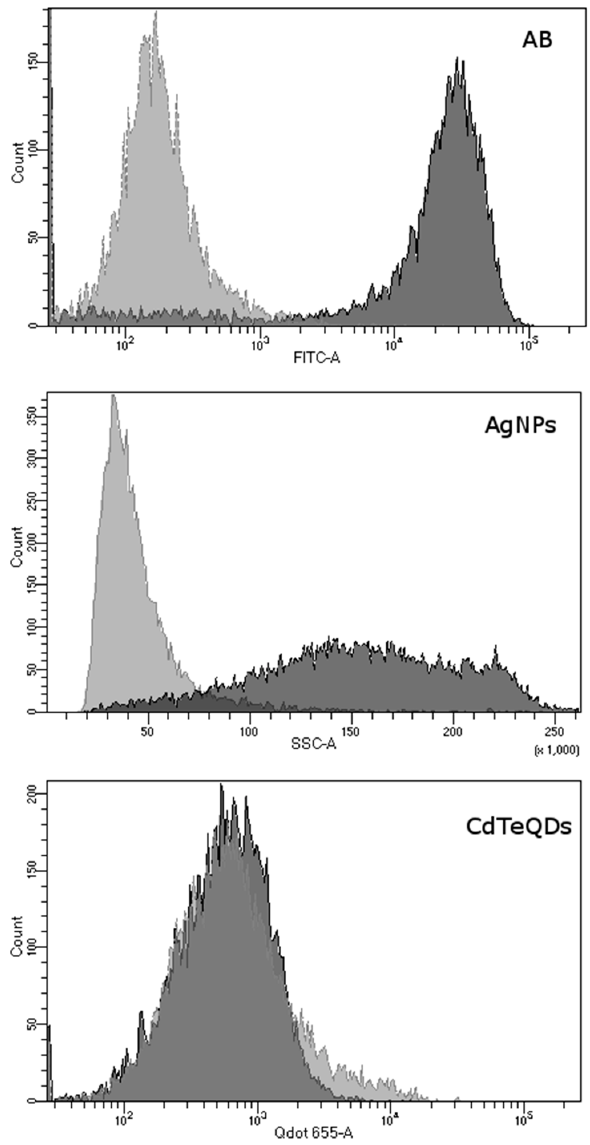
Figure 6. Uptake of A β , AgNP and CdTeQD by BV-2 cells preincubated with polyinosinic acid (PA). The cells were pretreated (or not) with PA, 50 µ g mL − 1 for 30 min, then A β -HiLyte Fluor 488 (0.1 µ M), AgNP (50 µ g mL − 1 ) or CdTeQD (10 µ g mL − 1 ) were added for 2 h. Light grey colored cells were pretreated with PA; dark grey colored cells were not treated with PA. Exemplary results of one of the experiments. Numerical data provided in Table 2.